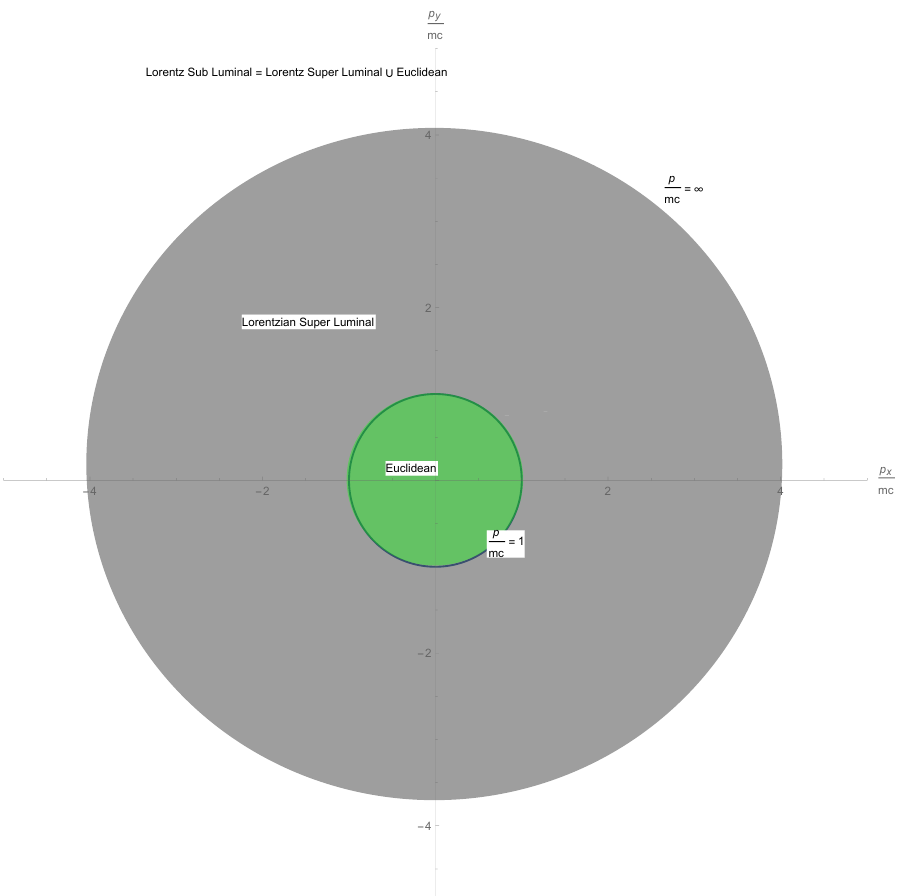
Figure 5. A depiction of the cross section of the momentum space for the cases considered: Euclidean (a compact sphere) in green, Lorentzian superluminal (an infinite domain with a spherical hall) in gray, and Lorentzian subluminal (the entire momentum plane). The latter is a union of the